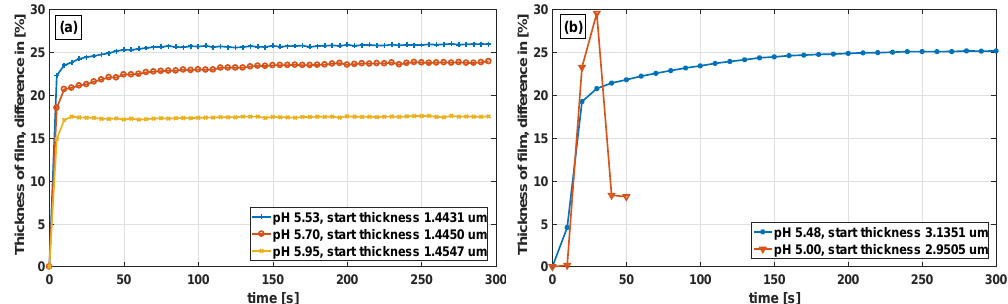
Figure 5. behavior of 1,3-OBAE mole ratio 2:1 that was exposed to different pH values. A value of 0% on the Y-axis equals the film’s dry thickness before any pH solution is added. In ( a ) the response for a 1.4 µ m thick film in pH 5.53, 5.70 and 5.95 and in ( b ) the blue (- ∗ -) curve shows the response of a 3.1 µ m thick film in pH 5.48, where it can be seen that a thicker film is slower in its response to